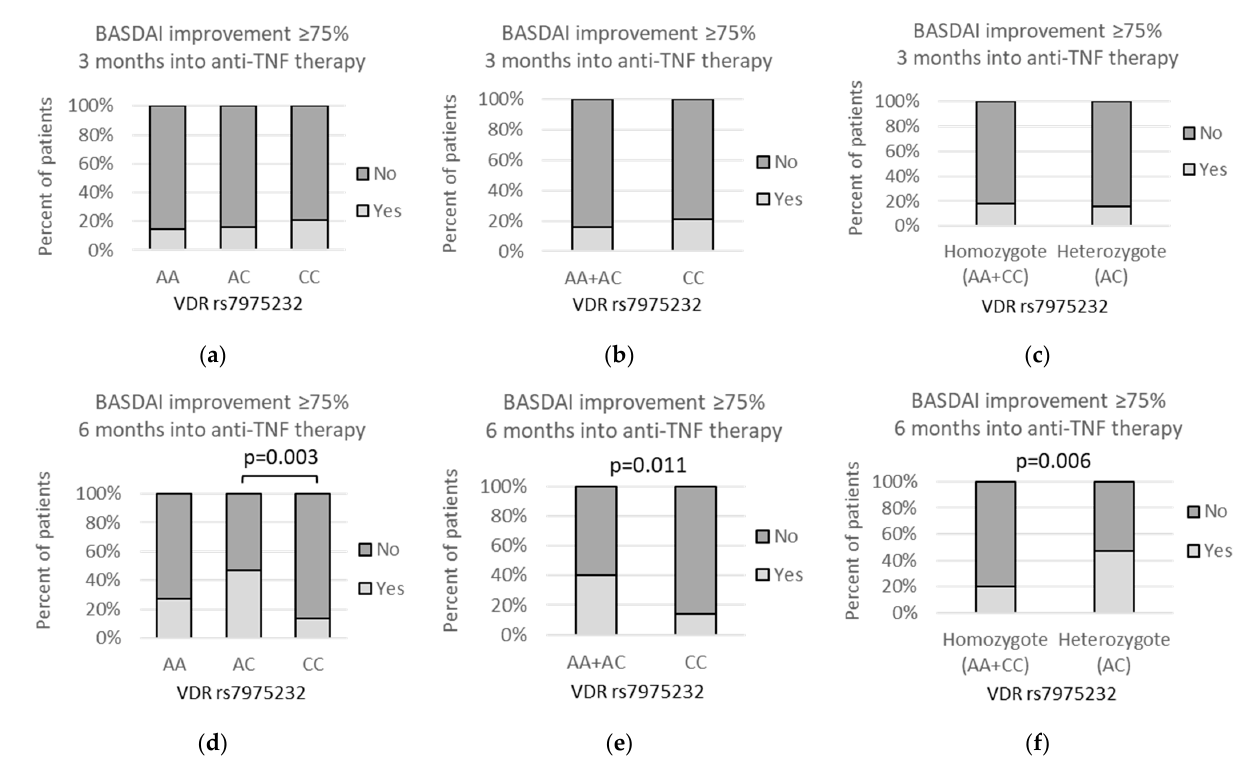
Figure 11. Relationships between VDR rs7975232 genetic variants and percent of patients with BASDAI improvement ≥ 75% after ( a – c ) 3 months and ( d – f ) 6 months into the anti-TNF treatment. The following statistically significant associations were found after 6 months of the therapy: ( d ) AC vs. CC , p = 0.003, OR(95%CI) = 5.53 (1.67 to 16.2); ( e ) AA + AC vs. CC , p = 0.011, OR(95%CI) = 4.17 (1.40 to 11.9); and ( f ) AA + CC vs. AC , p = 0.006, OR(95%CI) = 0.28 (0.12 to 0.65). Analysis was performed using Fisher‘s exact test.